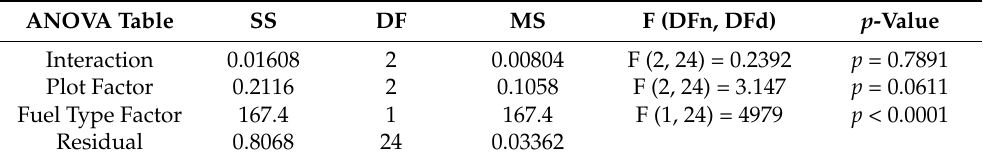
Table 4. Two-way ANOVA of volatile oil contents in live branches and surface dead fuel of P. yunnanensis